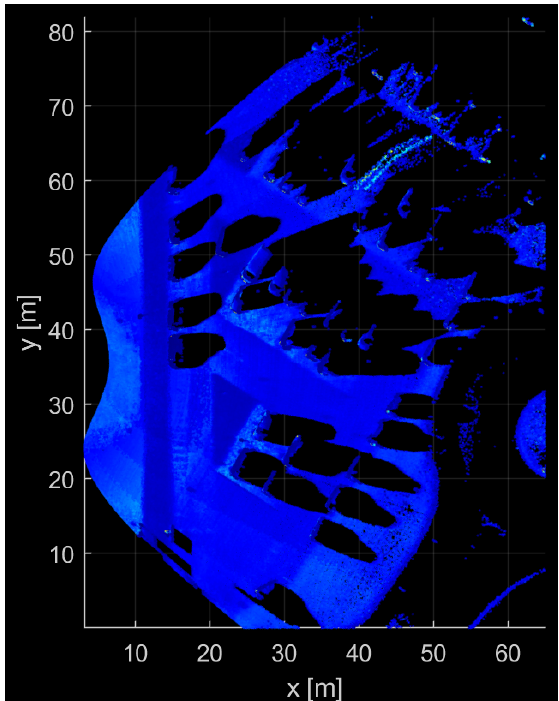
Figure 3. LiDAR map of the test area (top